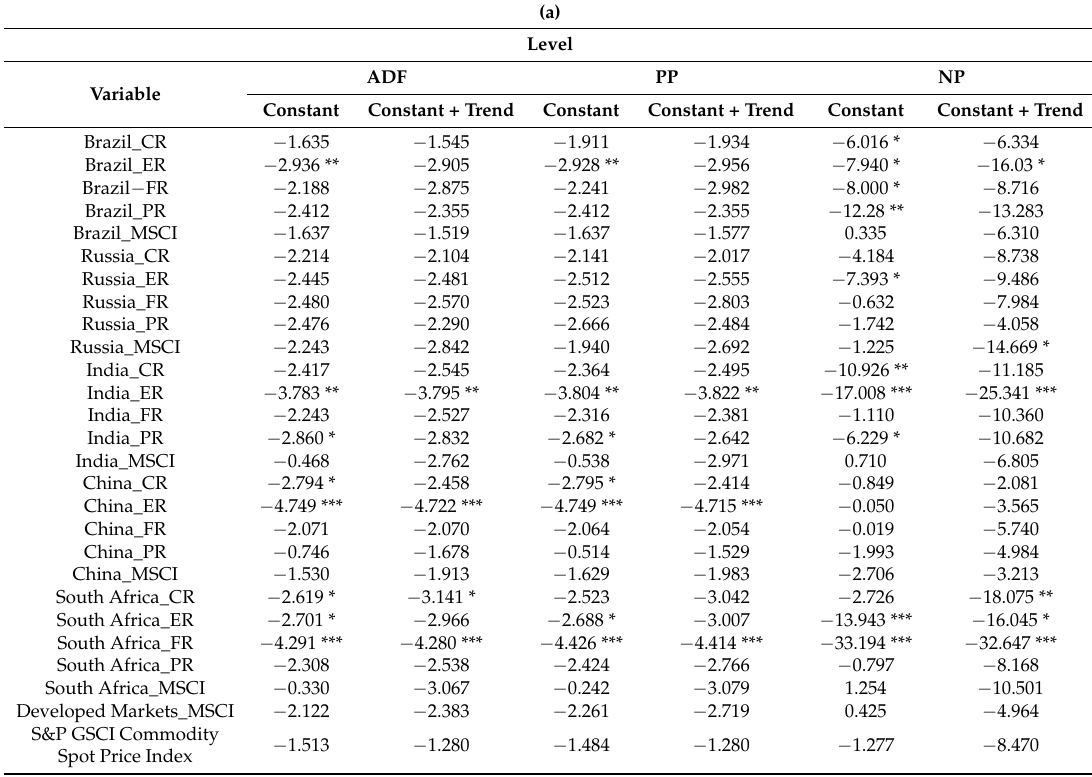
Table A2. Unit root test